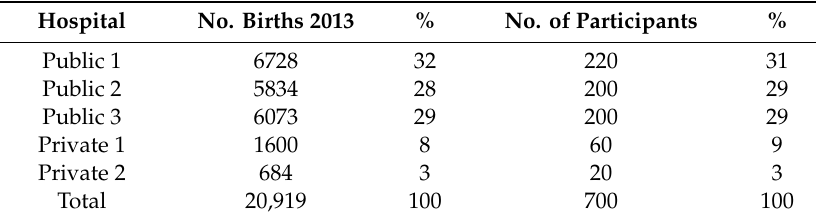
Table 1. Number of participants recruited from each